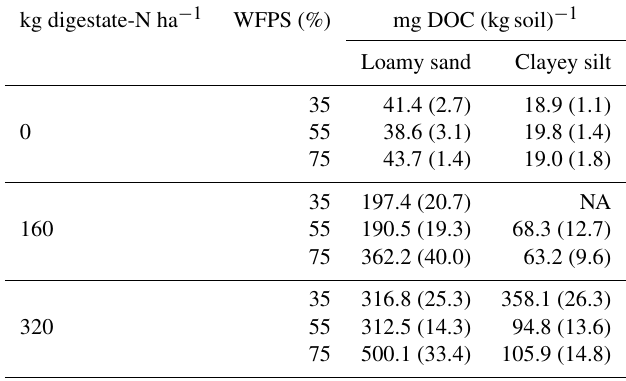
Table 4. Mean DOC values from soils, measured after incubation, with standard deviations in parentheses for the respective treatments differing in amount of applied biogas digestate (BD) and water-filled pore space (WFPS).